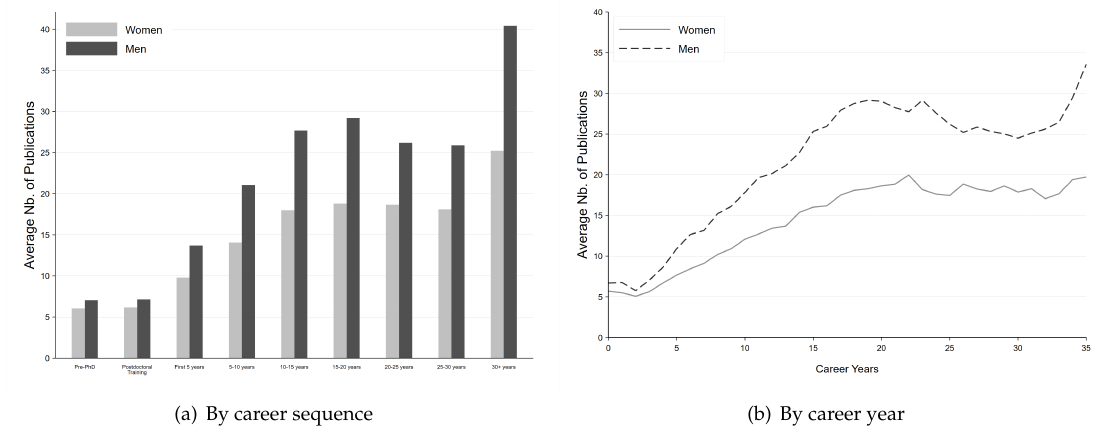
Figure 1: Publication rates—scientist level. Notes : Publication rates by gender over the career by career sequence (Panel A) and individual year (Panel B). In Panel A, t tests indicate that the difference between publication rates for men and women is statistically significant at the 1 percent level at every career stage. In Panel B, year 0 corresponds to the year of PhD receipt. In both panels, but especially Panel B, recall that the number of scientists in the cells corresponding to the most advanced stage of the career is relatively small (for example, in year 35, we observe only 452 scientists—372 men and 80 women). The remainder of the sample has either exited already or is not yet “of age,” as they entered in the sample after 1980 and the last year of observation is